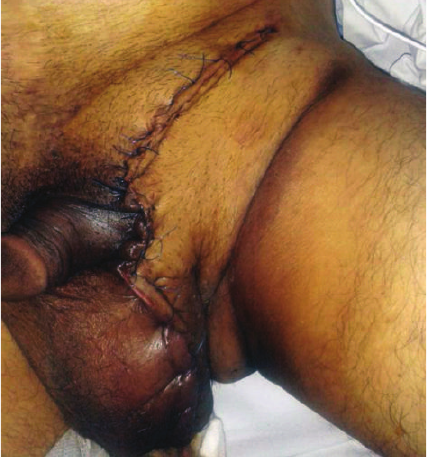
Figure 1: Preoperative view of left scrotal inguinal hernia.